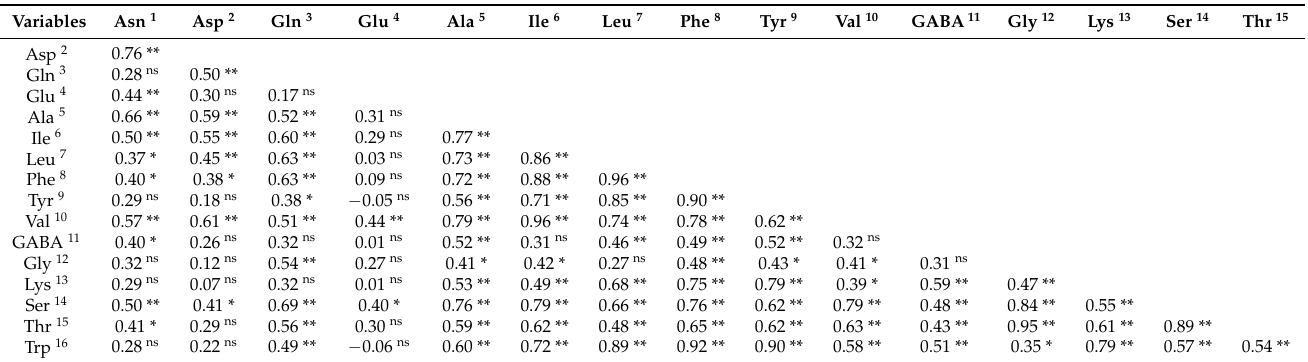
Table 6. Pearson’s linear correlations (r) between free amino acids in PH-16 dry cacao beans in 12 crop sites in the humid zone of southeast Bahia, Brazil.